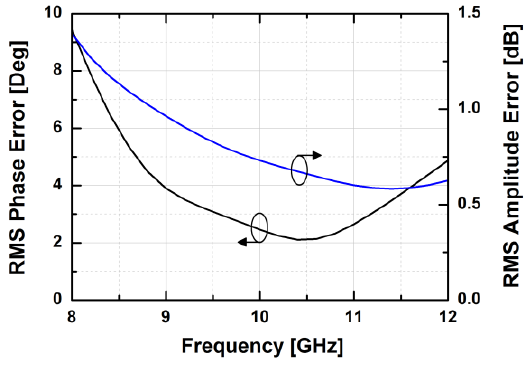
Figure 8. The RMS phase and amplitude errors in all of the phase shifter’s phase shift states.